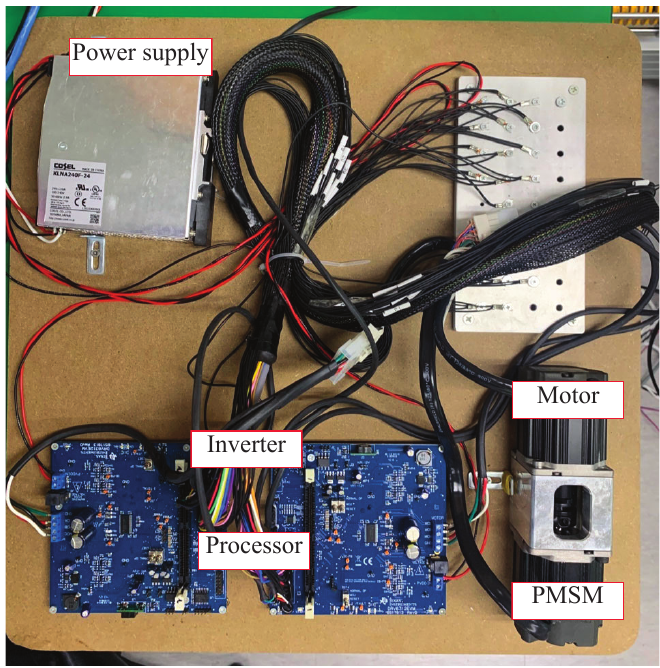
Figure 7. Experimental